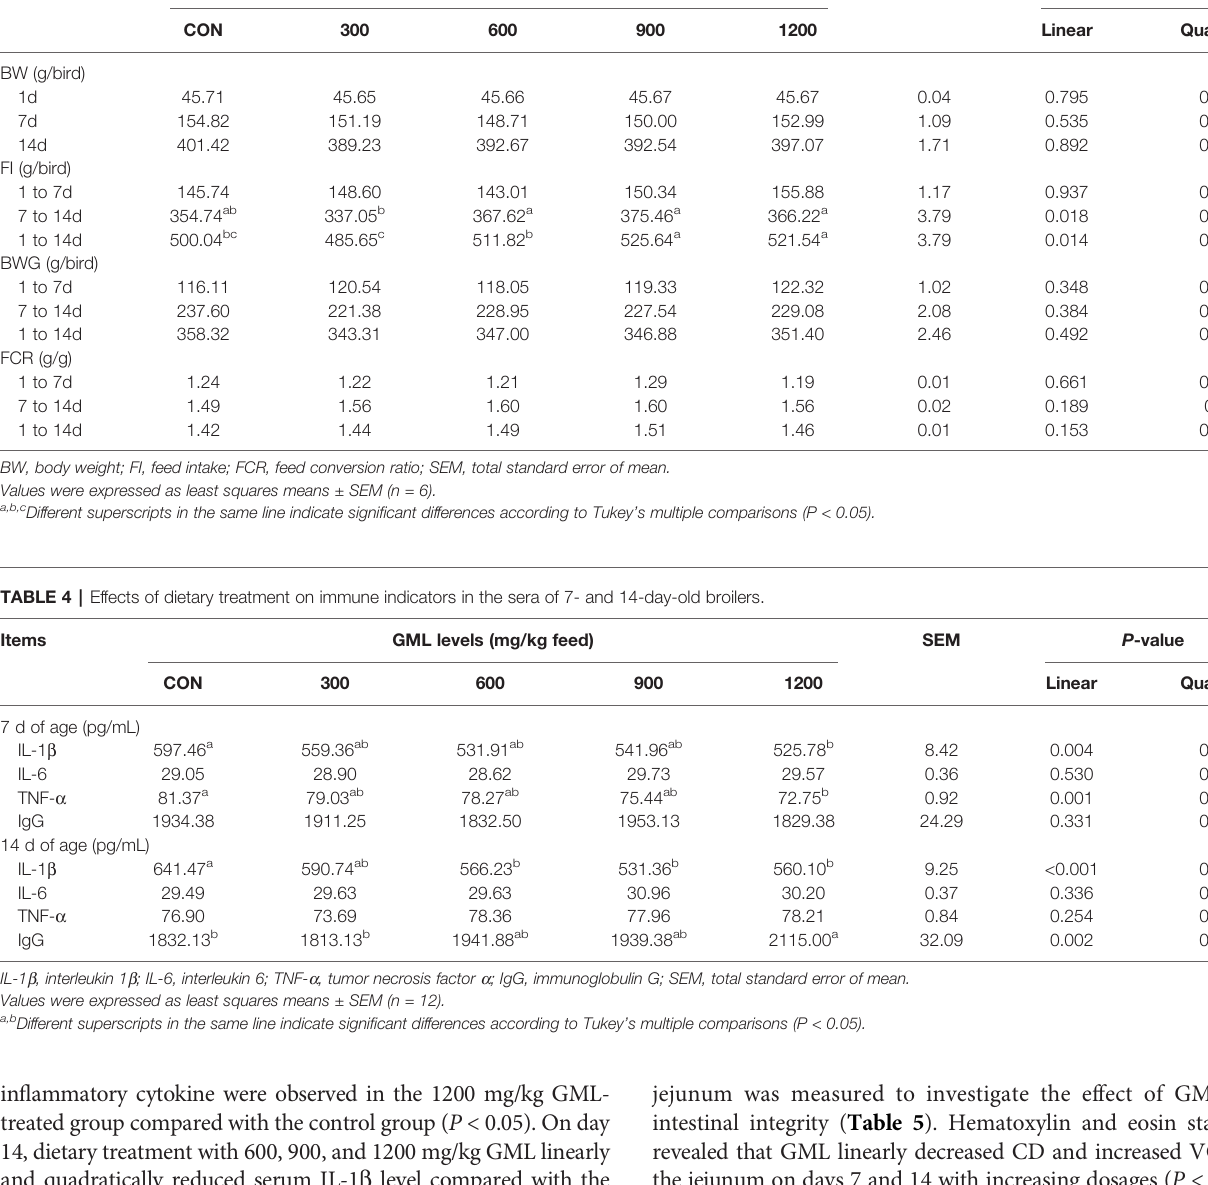
TABLE 3 | Effects of dietary treatment on growth performance in 7- and 14-day-old broilers. Items